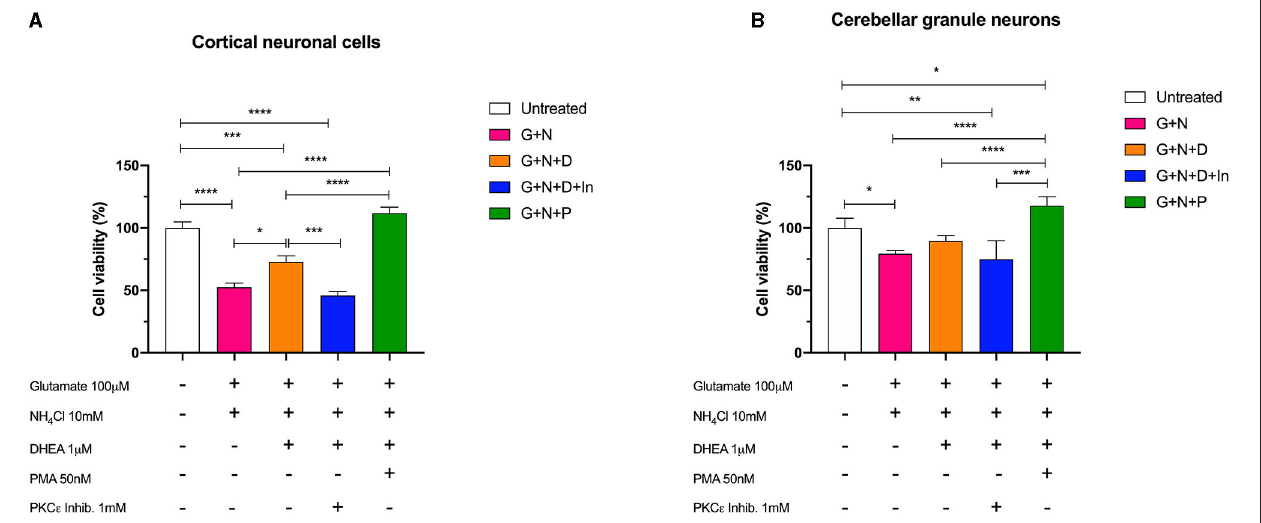
FIGURE 5 | Cell viability assay of (A) cerebellar cells and (B) cortical cells following 24h of incubation with glutamate (G), ammonium chloride (N), DHEA (D), PMA (P), and PKC ε inhibitor (In); * p < 0.05, ** p < 0.01, *** p < 0.001, **** p <